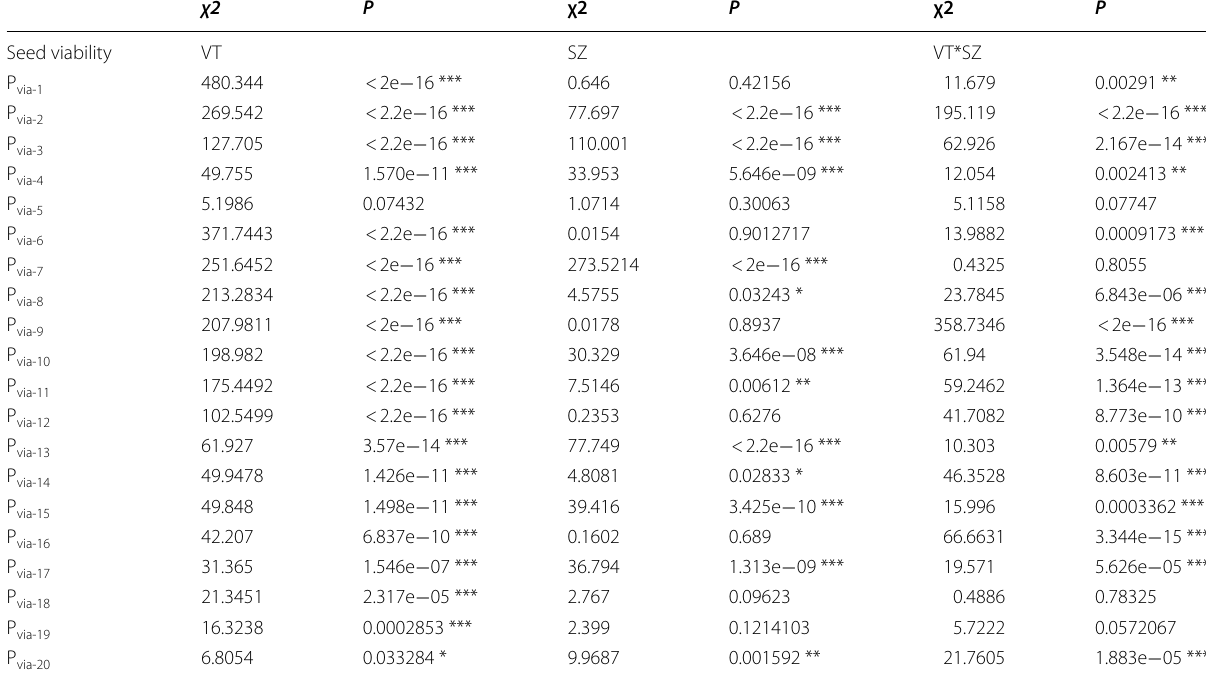
Results of Beta-Binomial models tested for 20 orchid species. P via is the viability percentage as the response for each species with serial number 1 to 20 as allocated in the Table 1, for all epiphytic species (1–5), followed by all terrestrial species (6–20). The VT is the viability test, SZ is the sterilization status and VT*SZ is the interaction between VT and SZ. The values marked *** are of highest significance (p <